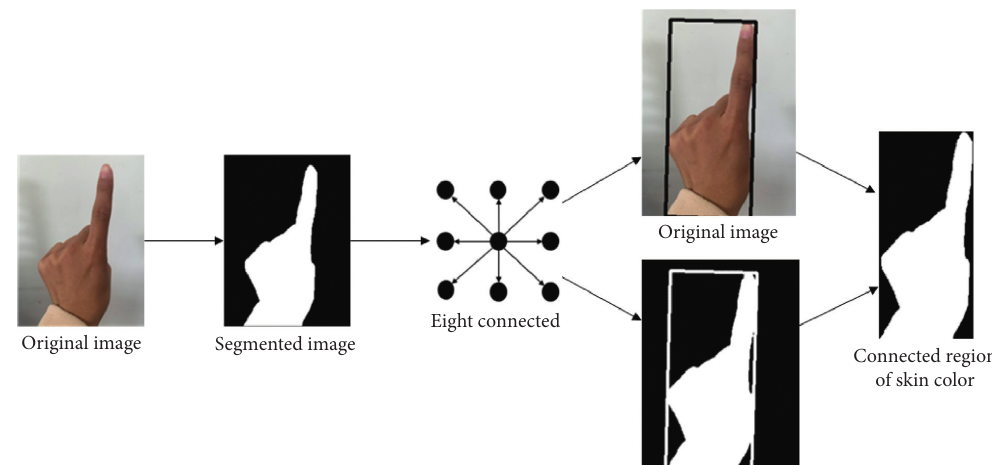
Figure 4: Contour filling